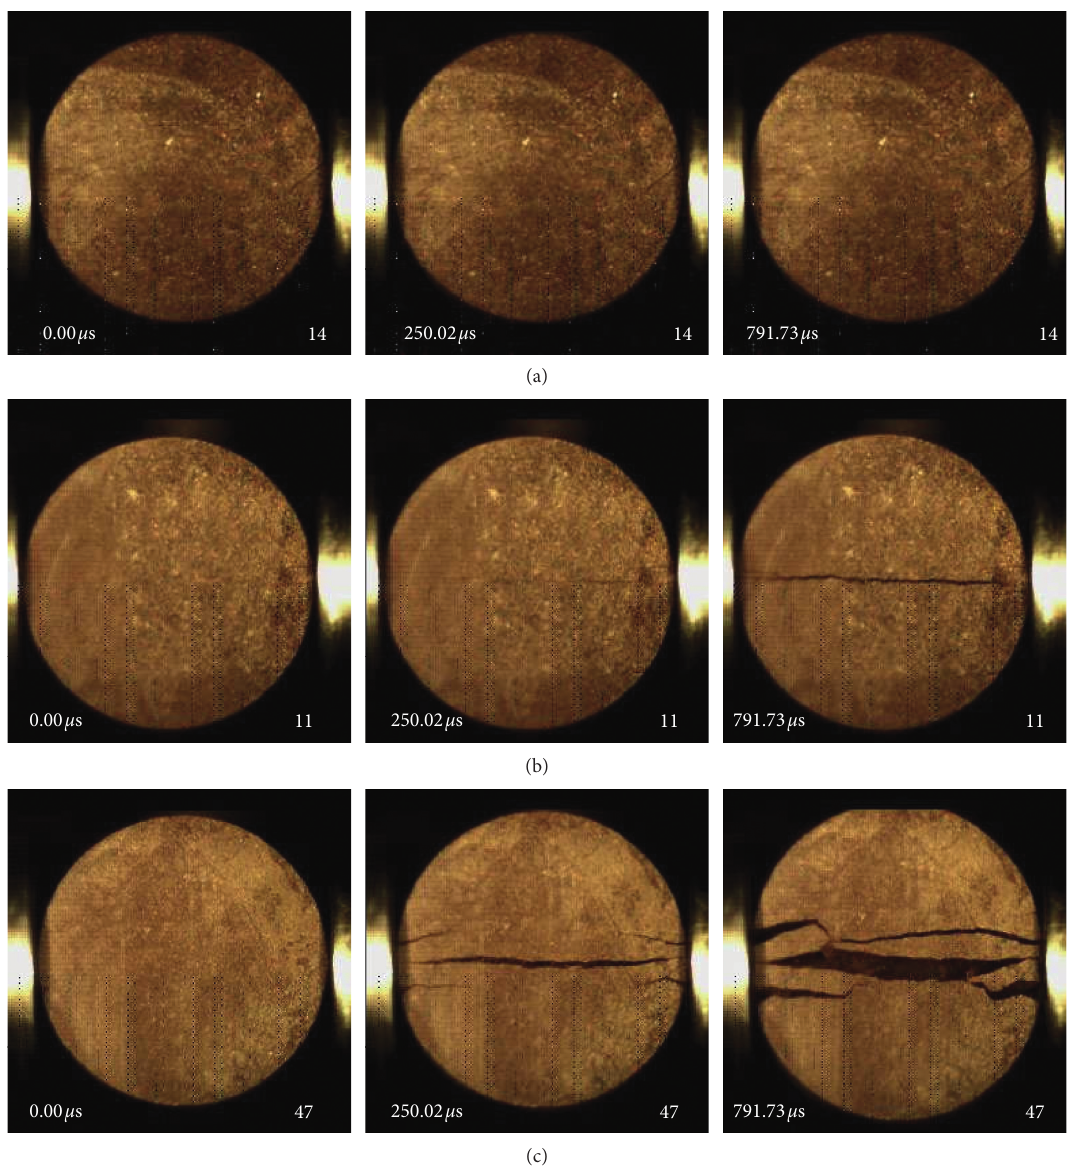
Figure 7: Failure processes of specimens in three states: (a) unruptured state; (b) ruptured state; (c) broken